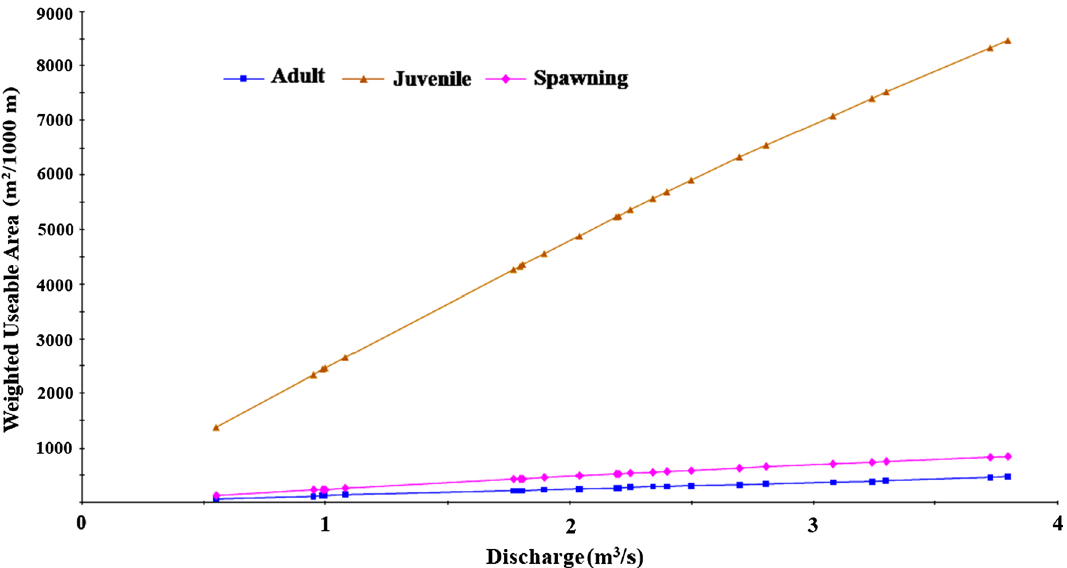
Fig.7 Discharge-weighted useable area for the Rutilus frisii kutum during three stages of juvenile fish, adult fish, and spawning in the Qarasu river